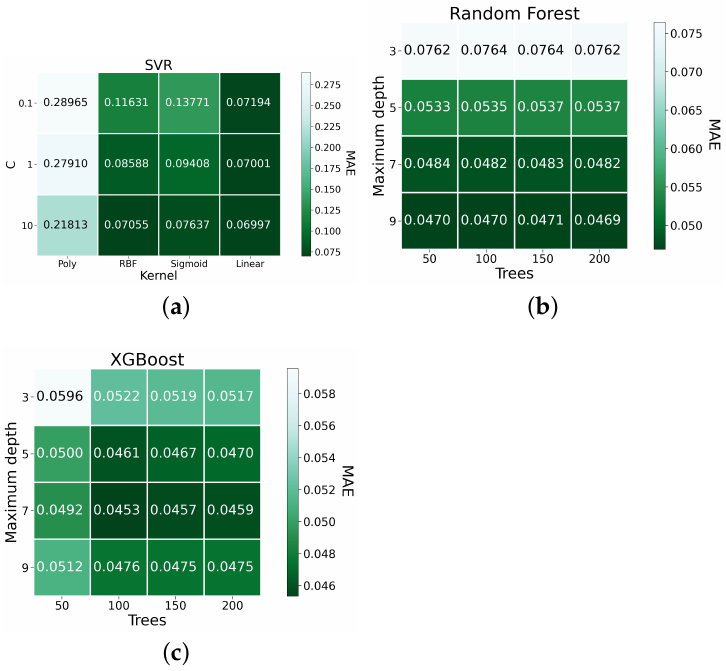
Figure 4. MAE grid search result for ( a ) SVR; ( b ) Random Forest; and ( c )